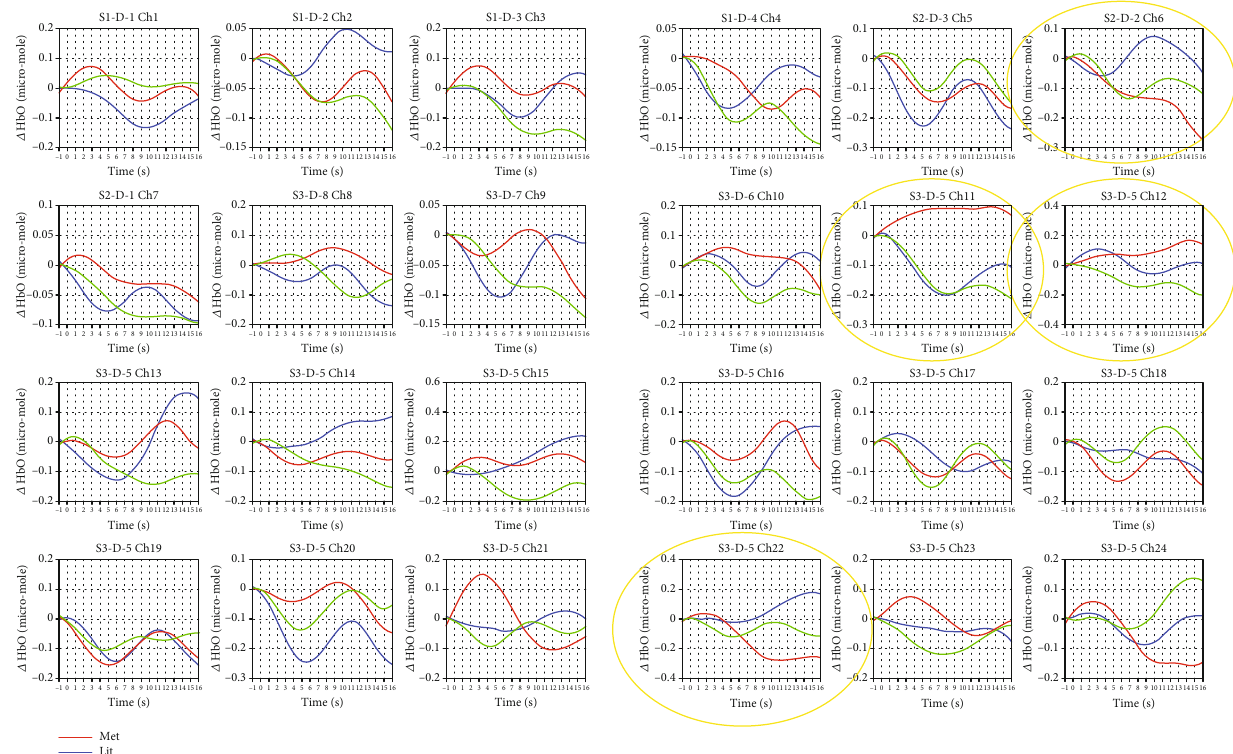
Figure 2: Haemodynamic average changes. Signi fi cant di ff erences were only activated in metaphor condition: Broca ’ s area left IFG/channel 06; contralateral side of Broca ’ s area right IFG/channel 11 and channel 12; contralateral side of Wernicke ’ s area right MTG/channel 22 ( p < 0 : 05 ∗ ); and nonsigni fi cant activation Wernicke left MTG/channel 14 ( p > 0 : 05